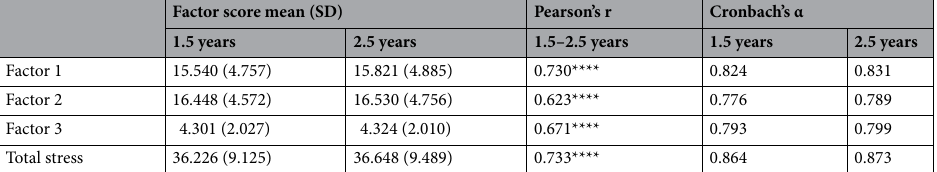
Table 4. Factor scores, Pearson’s correlation coefficients, and Cronbach’s α coefficients at the two postpartum parenting periods. SD standard deviation. **** p <